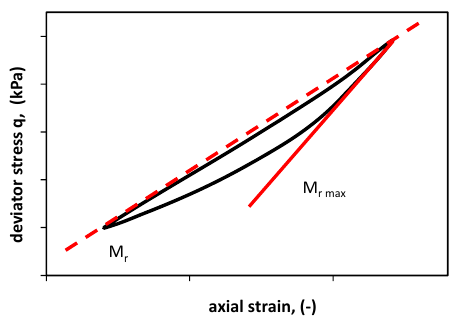
Figure 7. Schema of the hysteresis loop for M r and M r max calculations.